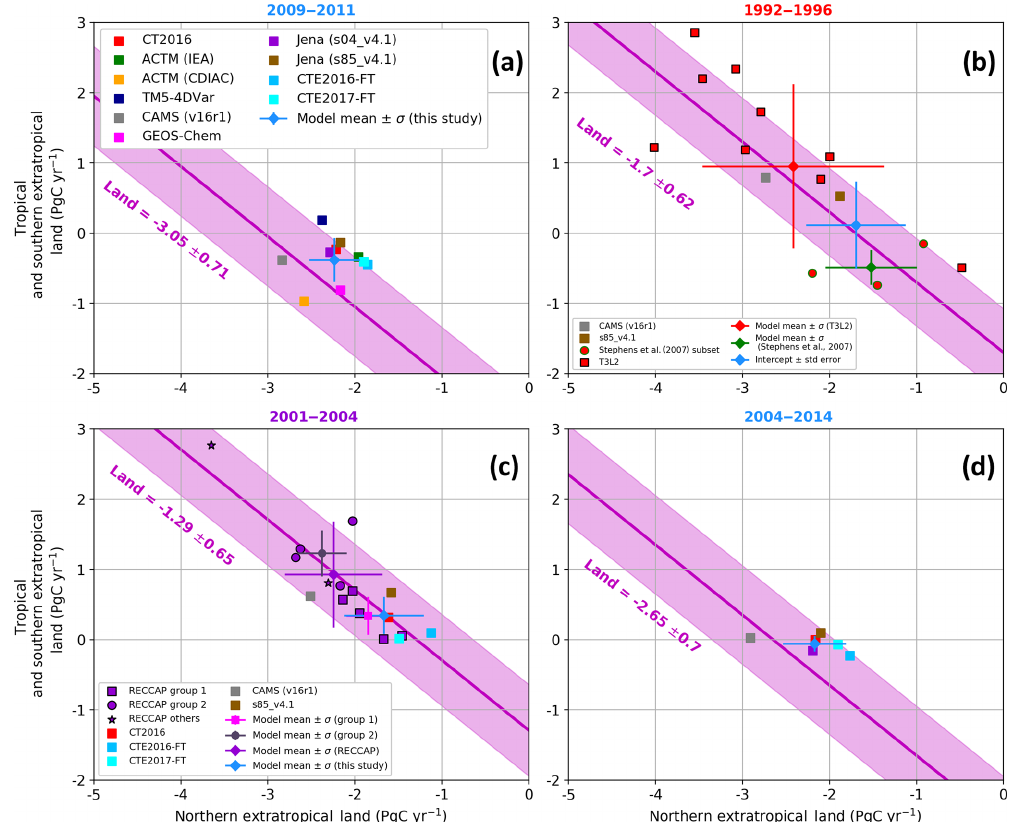
Figure 3. Tropical and southern extratropical (T+SET) versus northern extratropical (NET) land fluxes for the periods (a) 2009–2011, (b) 1992–1996, (c) 2001–2004, and (d) 2004–2014. The new models used in this study are represented by squares and the average of the available or selected simulations is shown in blue with 1 standard deviation error bars. The pink line and shaded area represents the GCP2016 (river adjusted) estimates of the total land sink for the given period. (a) Results for the HIPPO period 2009–2011; (b) results for the T3L2 period 1992–1996. The TransCom 3 Level 2 outputs (Gurney et al., 2004) are shown in red, with the vertical gradient selected models from Stephens et al. (2007) as circles outlined in green and the rest as red squares outlined in black. The intercept of the regression line with the observed vertical gradient (Fig. 2) is used to define our best flux estimate with error bars estimated by the standard error of the linear regression. (c) Results for the RECCAP period 2001–2004. Also, from Peylin et al. (2013), model means and standard deviations are shown in pink for the subgroup 1 (Jena, LSCEa, MACC-II, CTE2013, CT2011_oi) and in gray for the subgroup 2 (MATCH, CCAM, TrC, NICAM). Panel (d) shows the results from our new set of models for the period